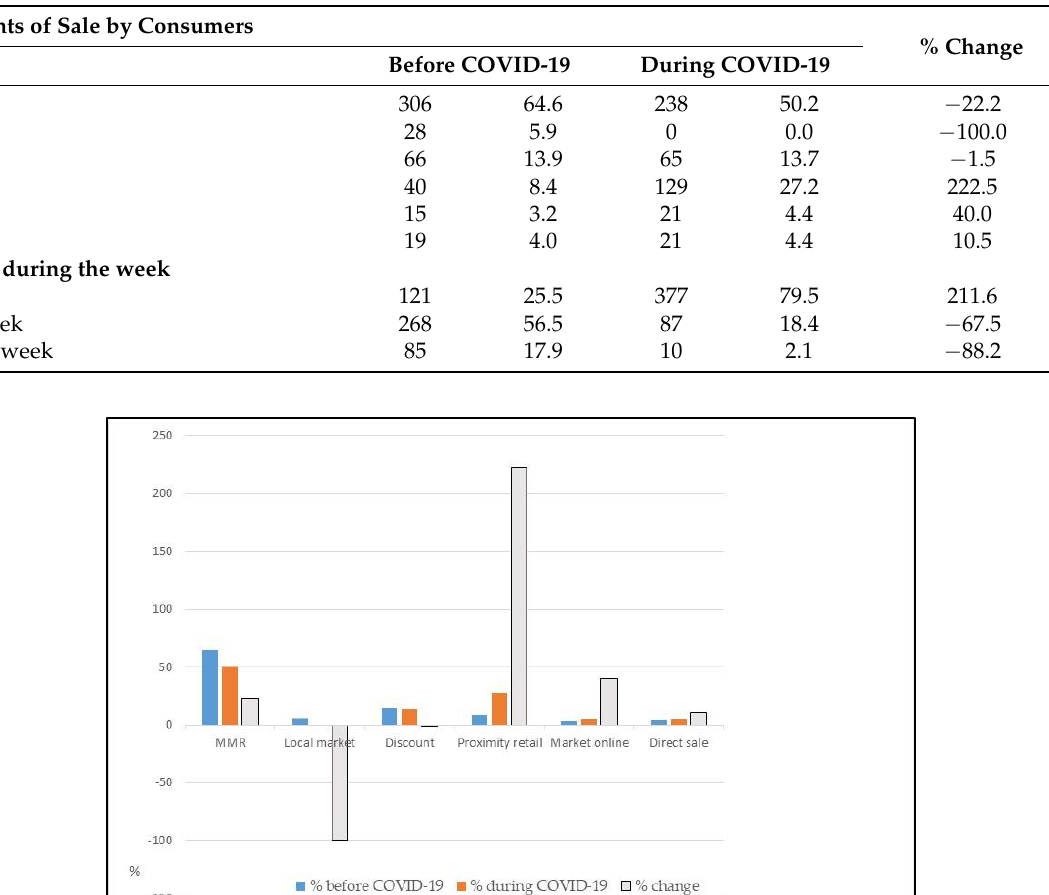
Table 10. Percentage variation of favorite points of sale by consumers and spending frequency during the week interviewed before and during the health emergency from COVID-19. Source: The authors.